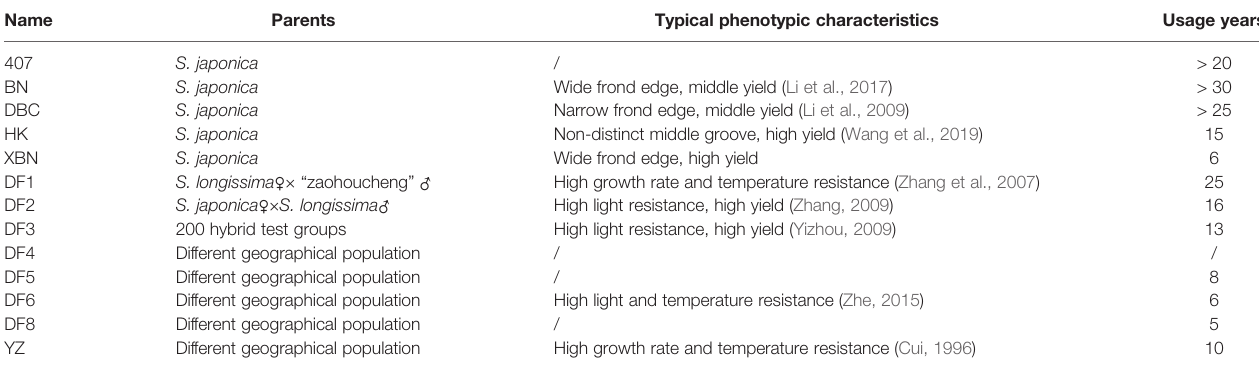
TABLE 3 | Information of cultivars breeding and phenotypic characteristics.